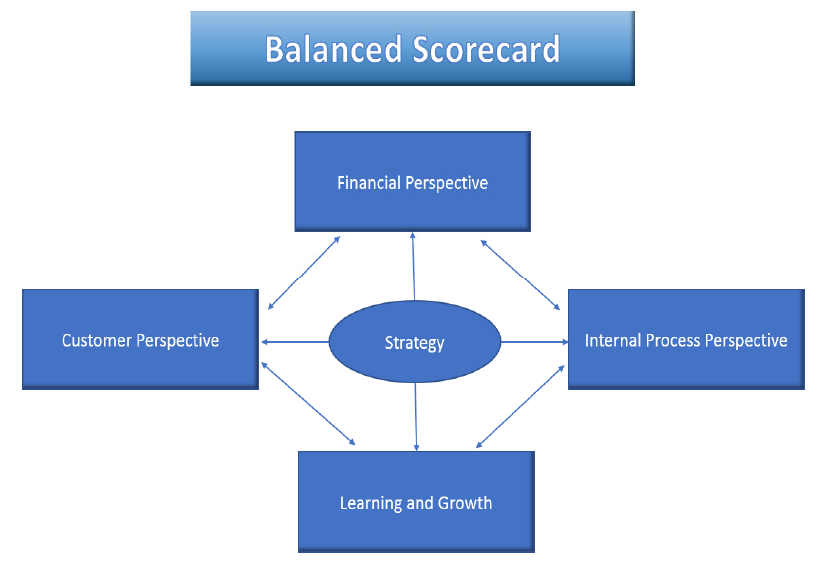
Figure 1. Balanced scorecard framework.